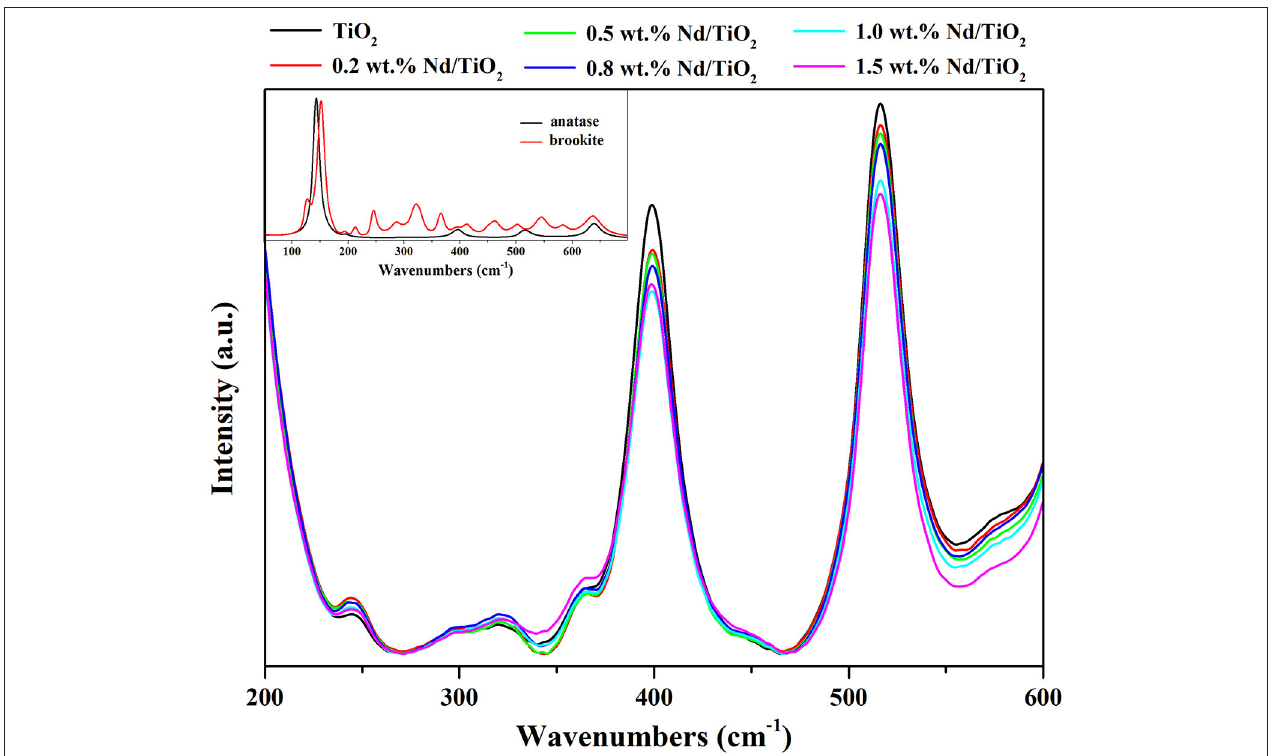
FIGURE 3 | Raman spectra of Nd/TiO 2 photocatalysts (main graph) and of pure TiO 2 anatase and brookite phases (inlet graph).